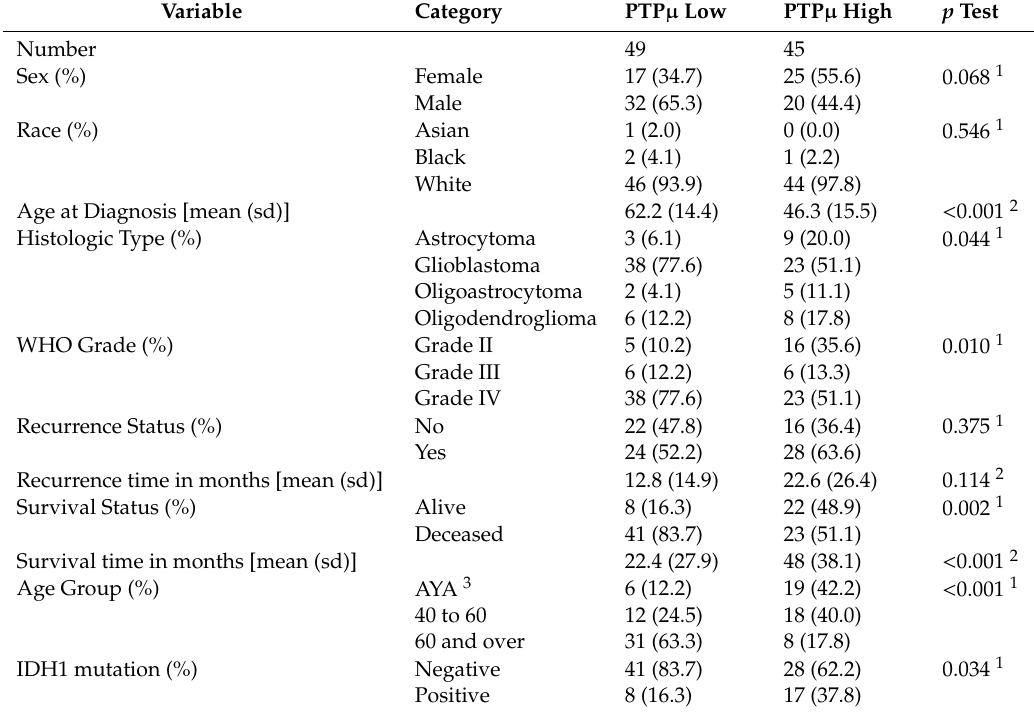
Table 1. Clinicopathological characteristics of glioma patients from the Ohio Brain Tumor Study with low and high staining for the PTP µ biomarker. The recurrence times indicated represent the mean recurrence times only for patients who had a recurrence. The mean survival times provided are for all patients